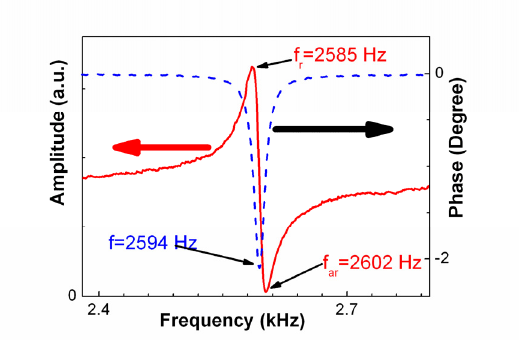
Figure 2. The frequency dependence of the phase and amplitude signals from the lock-in amplifier for an MSMC in size of 2.8 mm (L) x 1.0 mm (W) x 35 μ m (t) in